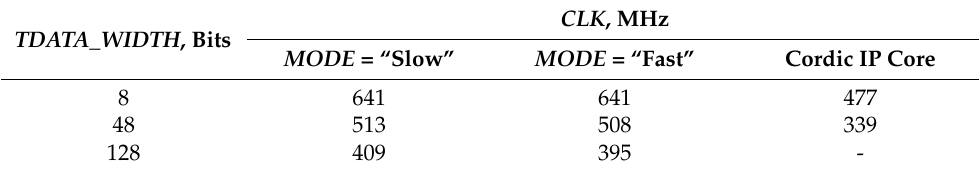
Table 3. Maximum system frequency of the IP core determined after